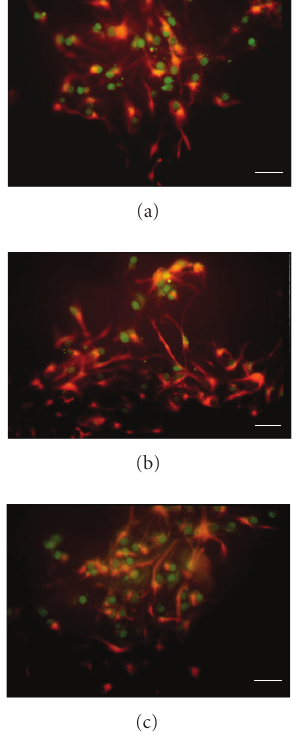
Figure 6: Double immunofluorescence staining for GFAP/PPAR in S10 neurospheres is shown. (a) PPAR α , (b) PPAR β , (c) PPAR γ . Bar = 30 μ